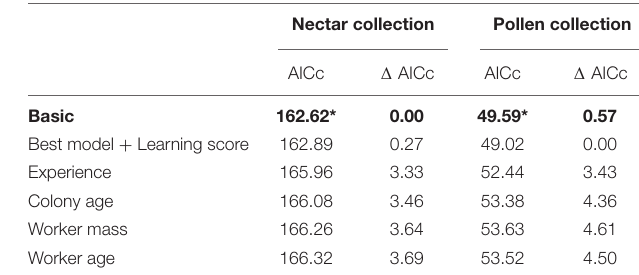
TABLE 2 | Candidate models to predict the nectar and pollen collection